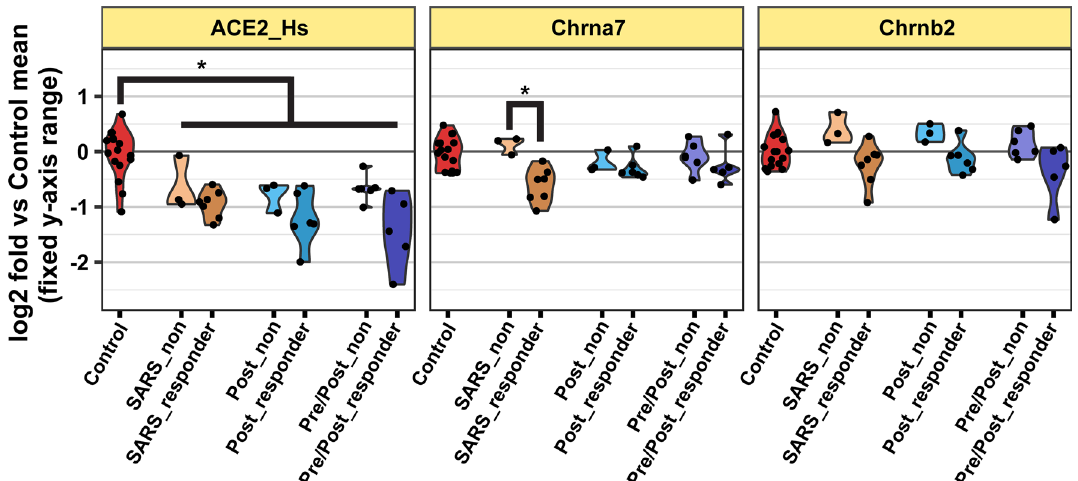
Figure 5. Gene expression of ACE2, Chrna7, and Chrnb2. Violin plots represent Neuropathology Panel derived log2 fold gene expression of ACE2 and nicotinic receptors of each exposure group separated by non- responders and responders relative to the control group. Data are centered around control averages. *Represents significantly altered gene regulation as defined with minimum expression of 32 normalized counts in one sample group, fold change at least 1.5, and Benjamini–Hochberg adjusted P -value below 0.05 controlling for all comparisons.